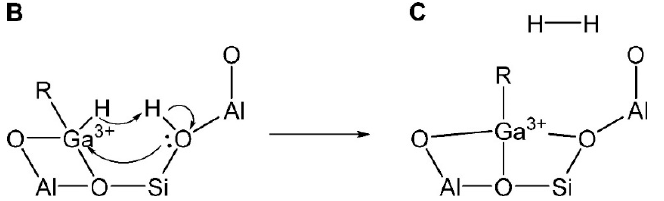
Figure 25. H 2 elimination from the LBAS. Reprinted with permission from ref [73]. Copyright 2018 American Chemical Society.